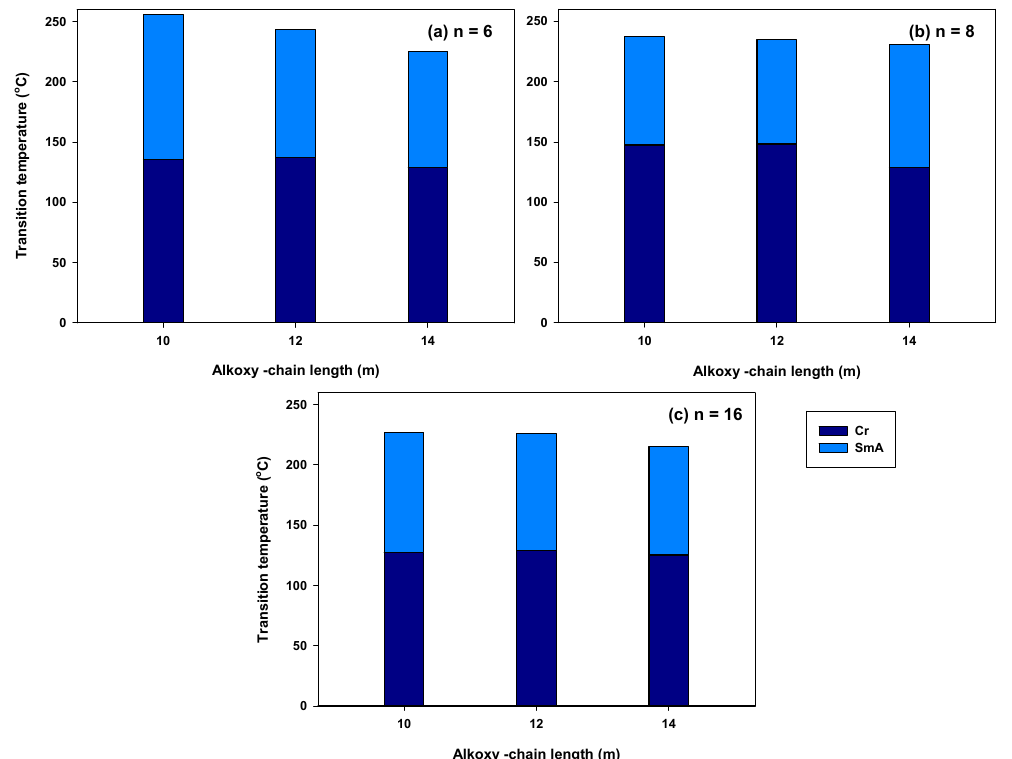
Figure 4. Graphical DSC transitions of 1:1 SMHBCs for ( a ) A6 / Bm ; ( b ) A8 / Bm and ( c ) A16 / Bm .